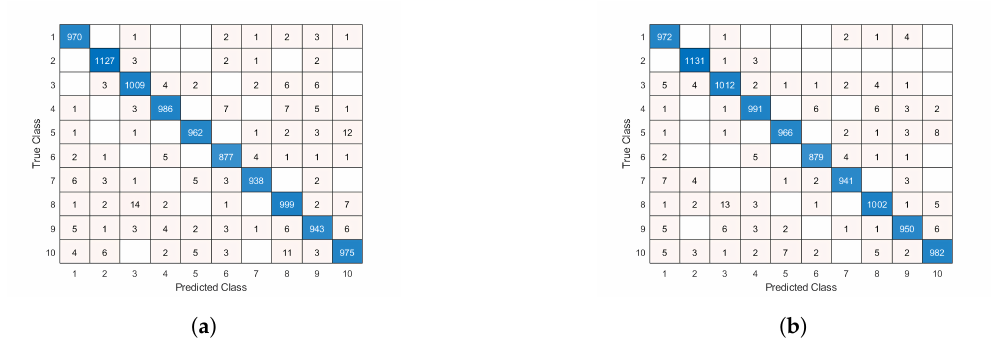
Figure 12. Confusion matrix of ( a ) the vanilla MNIST network topology and ( b ) the adaptive MNIST network topology.